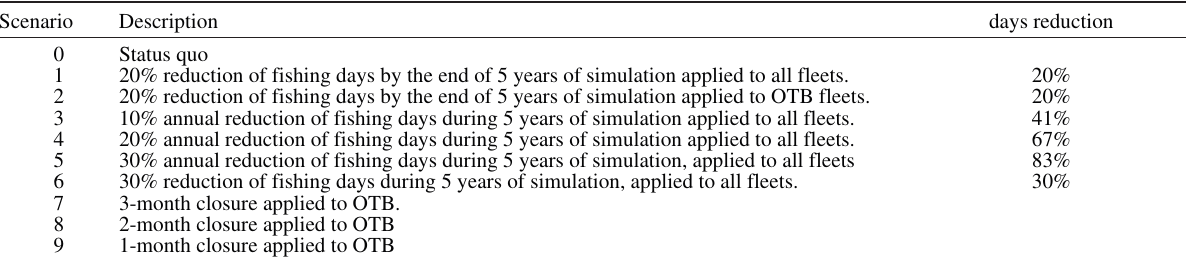
Table 6. – Simulation scenarios. The total fishing days reduction corresponding to each scenario by the end of the five-year simulation period is given in the right column. Scenario